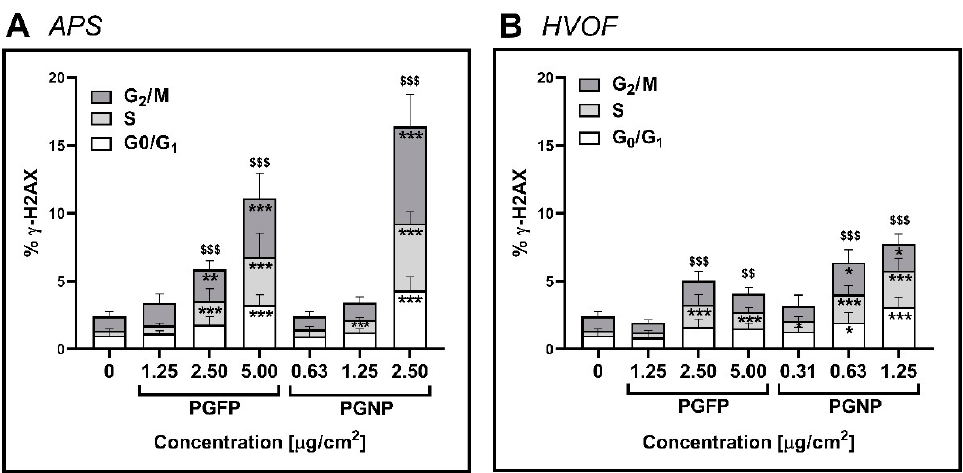
Figure 5. γ -H2AX in human alveolar epithelial cells after 24 h of exposure to PGFP and PGNP released during APS ( A ) and HVOF ( B ). Data are expressed as means ± standard deviations (n = 3–4). Data were analysed by one-way ANOVA followed by Dunnett’s post-hoc test. Global γ -H2AX analysis: $$ p ≤ 0.01 and $$$ p ≤ 0.001 vs. NC. γ -H2AX in each phase of cell cycle: * p ≤ 0.05, ** p ≤ 0.01 and *** p ≤ 0.001 vs. NC.